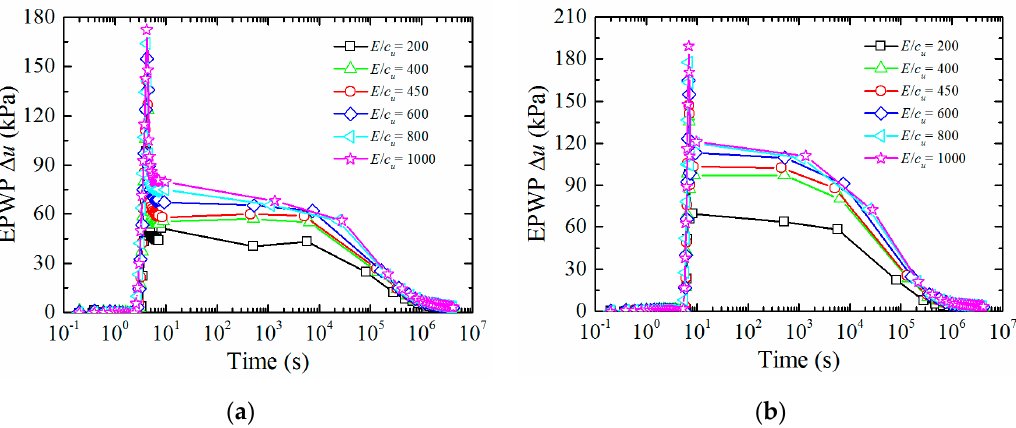
Figure 14. Development and dissipation of EPWPs during and after pile installation under various soil elastic moduli. ( a ) At depth of 4.9 m; ( b ) at depth of 7.5 m.